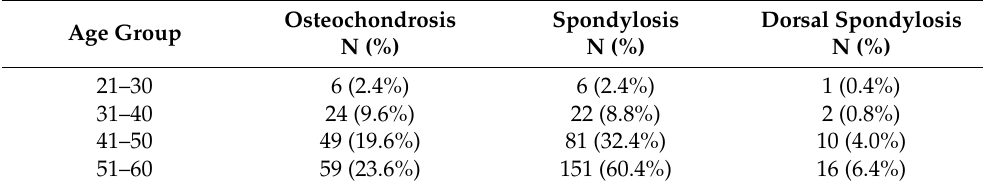
Table 4. List of osseous criteria for segment degeneration (number and proportion of segments with osteochondrosis, spondylosis and dorsal spondylosis for each age